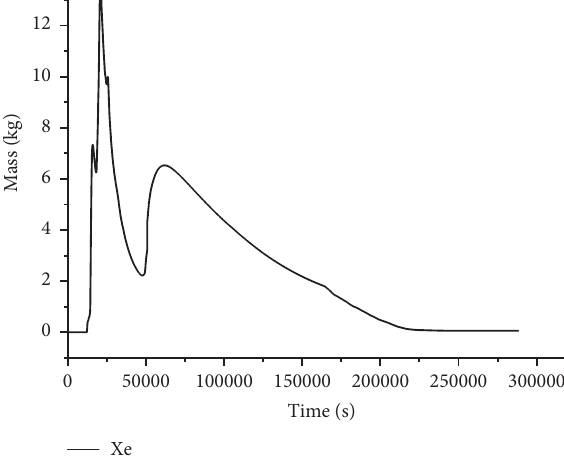
Figure 8: Release of Xe in